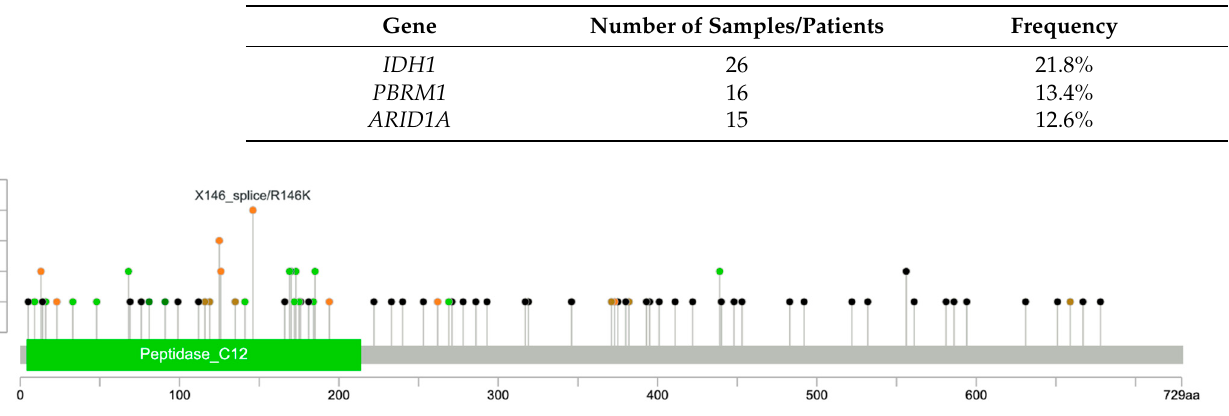
Figure 2. Lollipop plot showing the position of detected BAP1 mutations in the gene sequence.